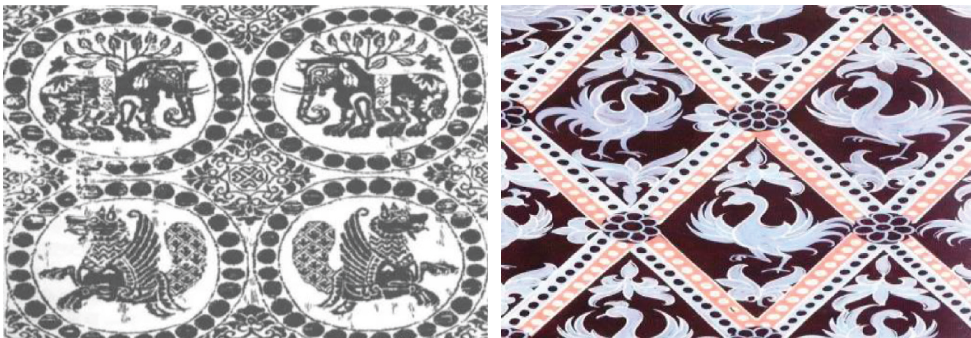
Figure 2: Animal patterns decorated in national costumes.